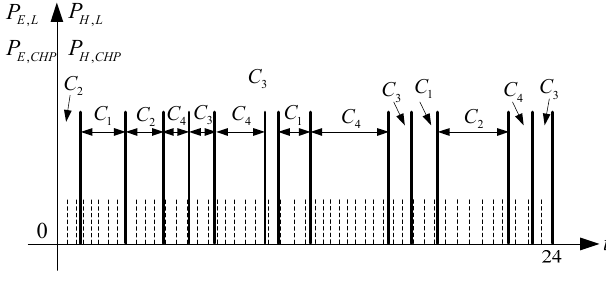
Figure 5. Operation modes identification for CHP.